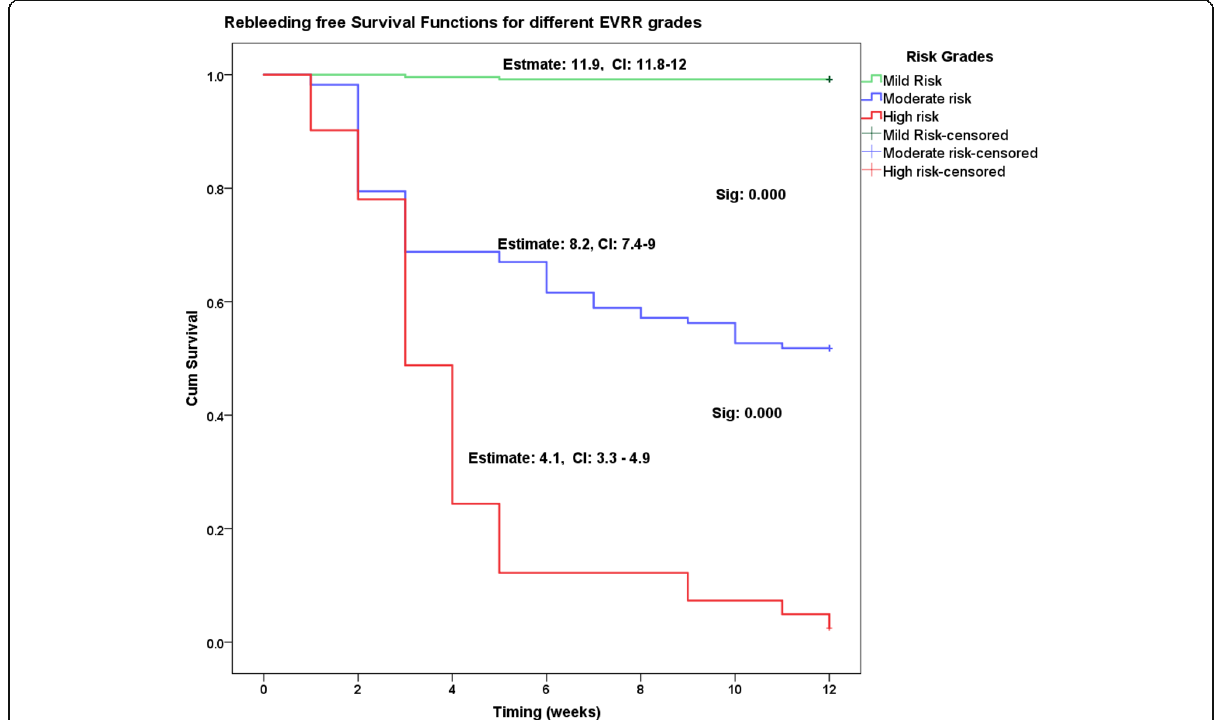
Fig. 3 Rebleeding free survival function for different grades of early variceal rebleeding risk